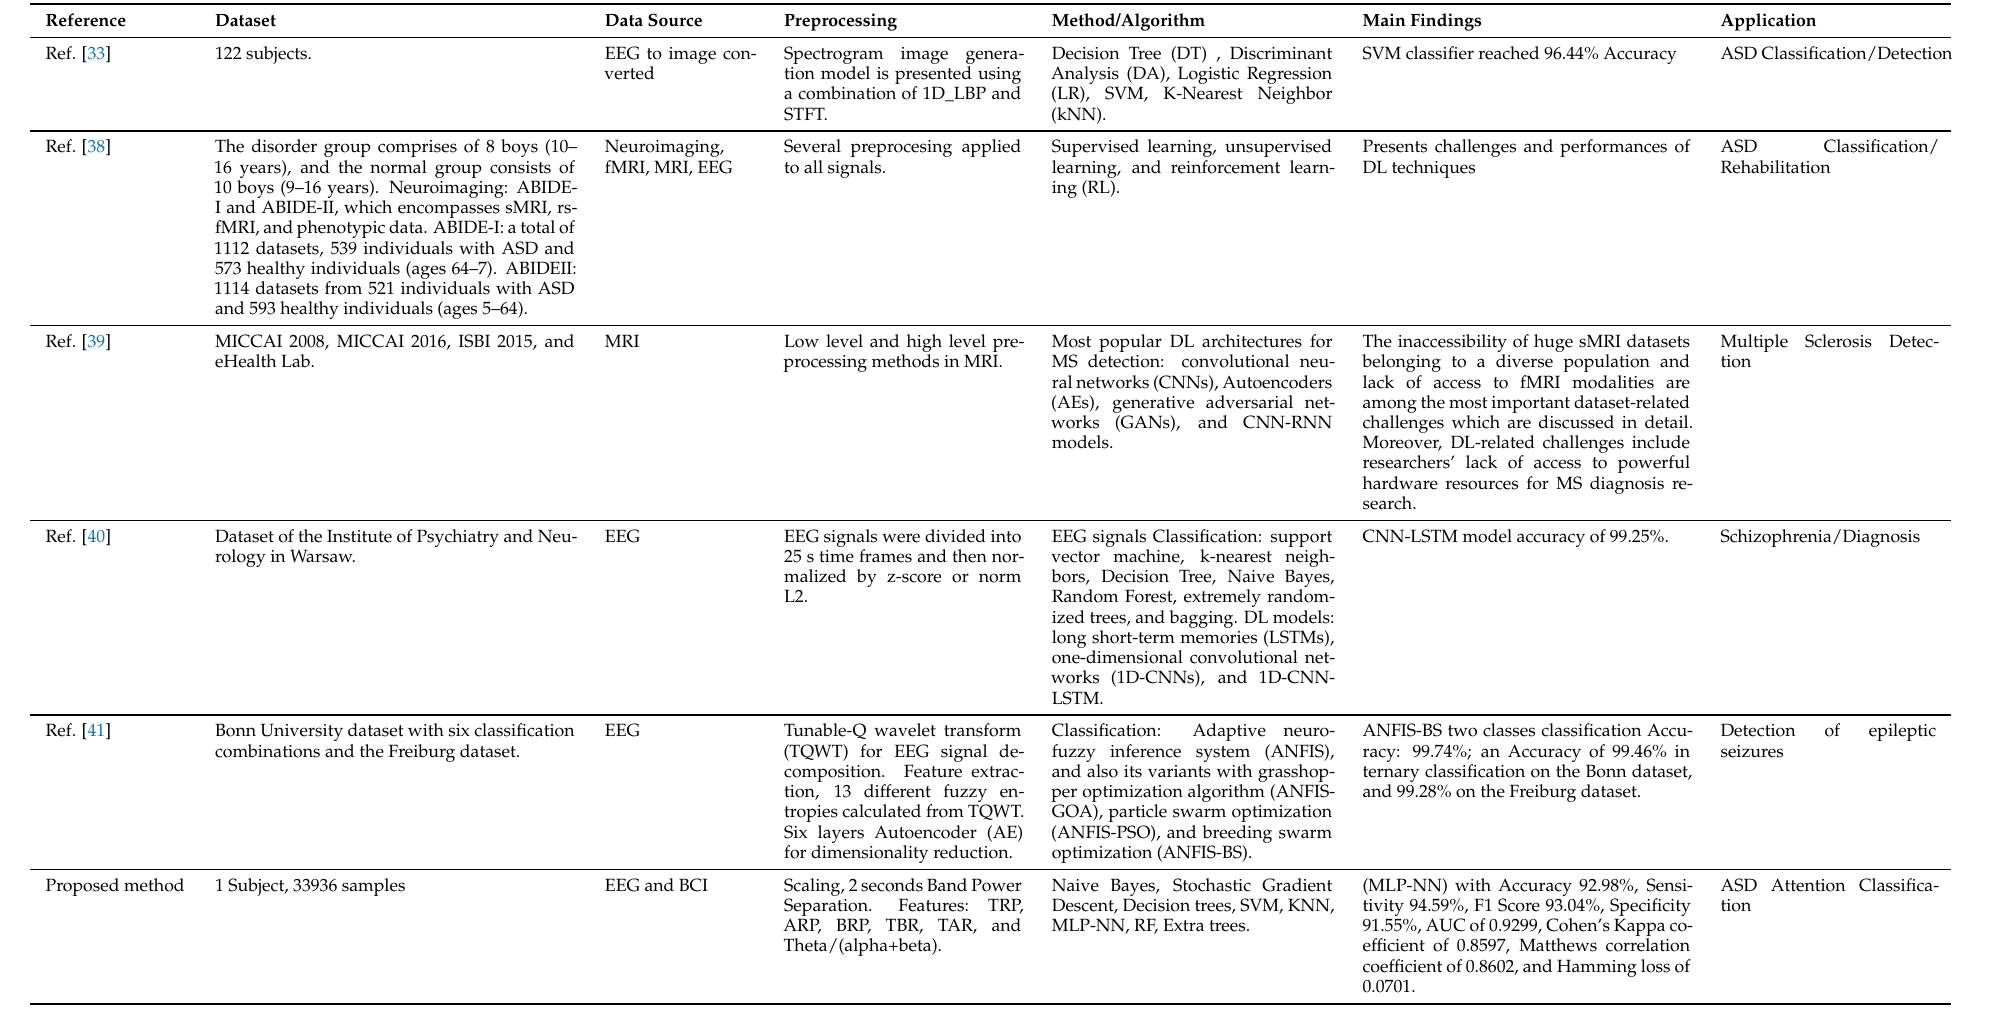
Table A2. State of the art, part